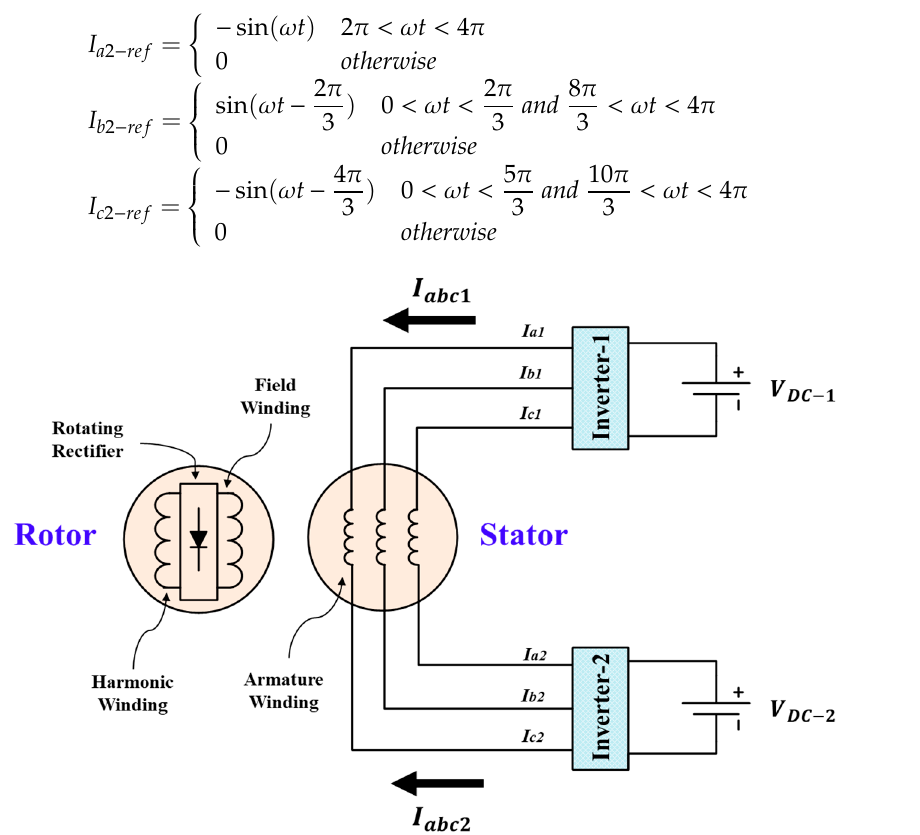
Figure 1. Machine topology.